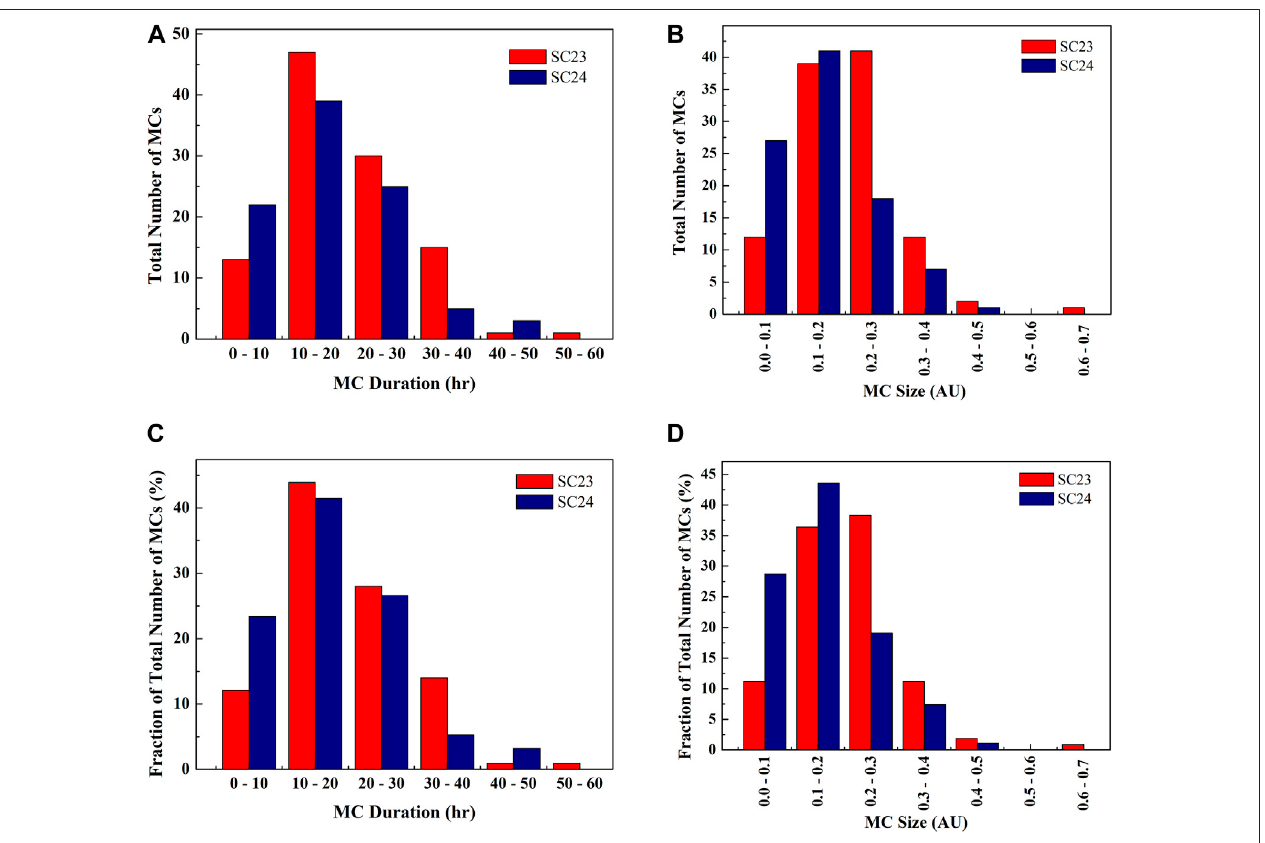
FIGURE 3 | The distributions of the duration and radial sizes of MCs for solar cycles 23 and 24 are shown. (A),(B) and (C),(D) show the distributions for the total number of MCs and the percentage fraction of the total number of MCs in each bin,